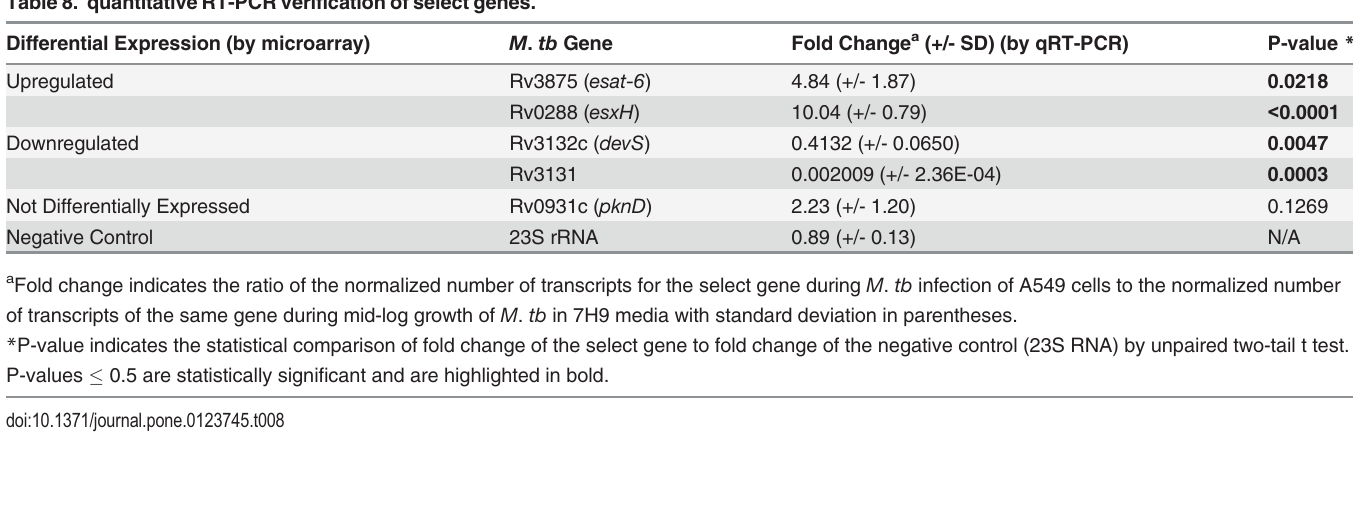
Table 8. quantitative RT-PCR verification of select genes. Differential Expression (by microarray)